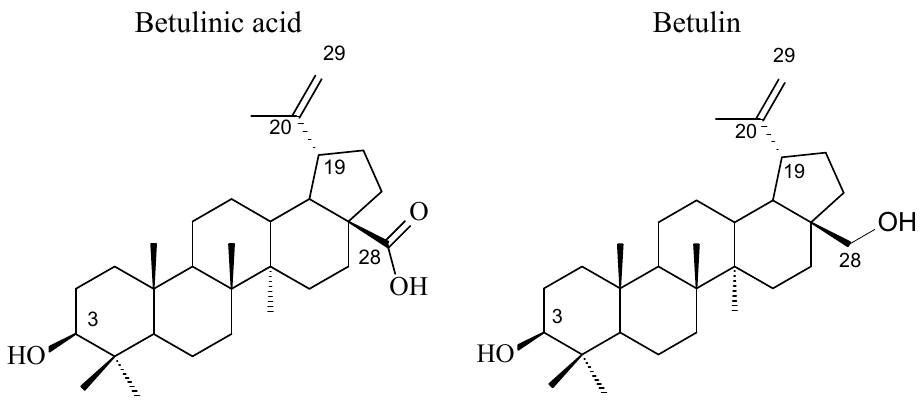
Figure 1. Structures of betulinic acid and